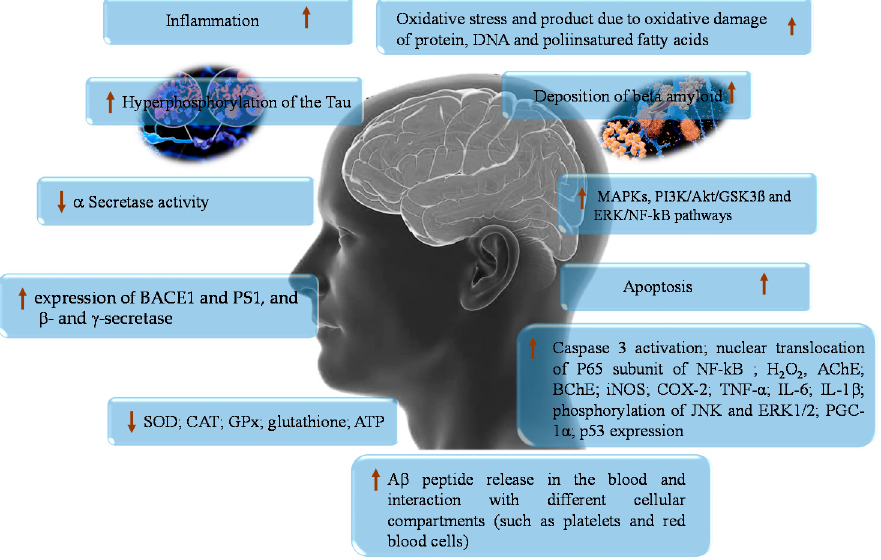
Figure 1. Schematic representation of the main features of Alzheimer’s disease. ( ↑ increase; ↓ de- crease).